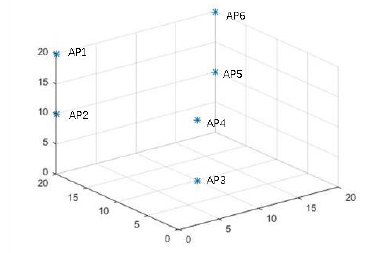
Figure 1 Simulation of the experimental environment and